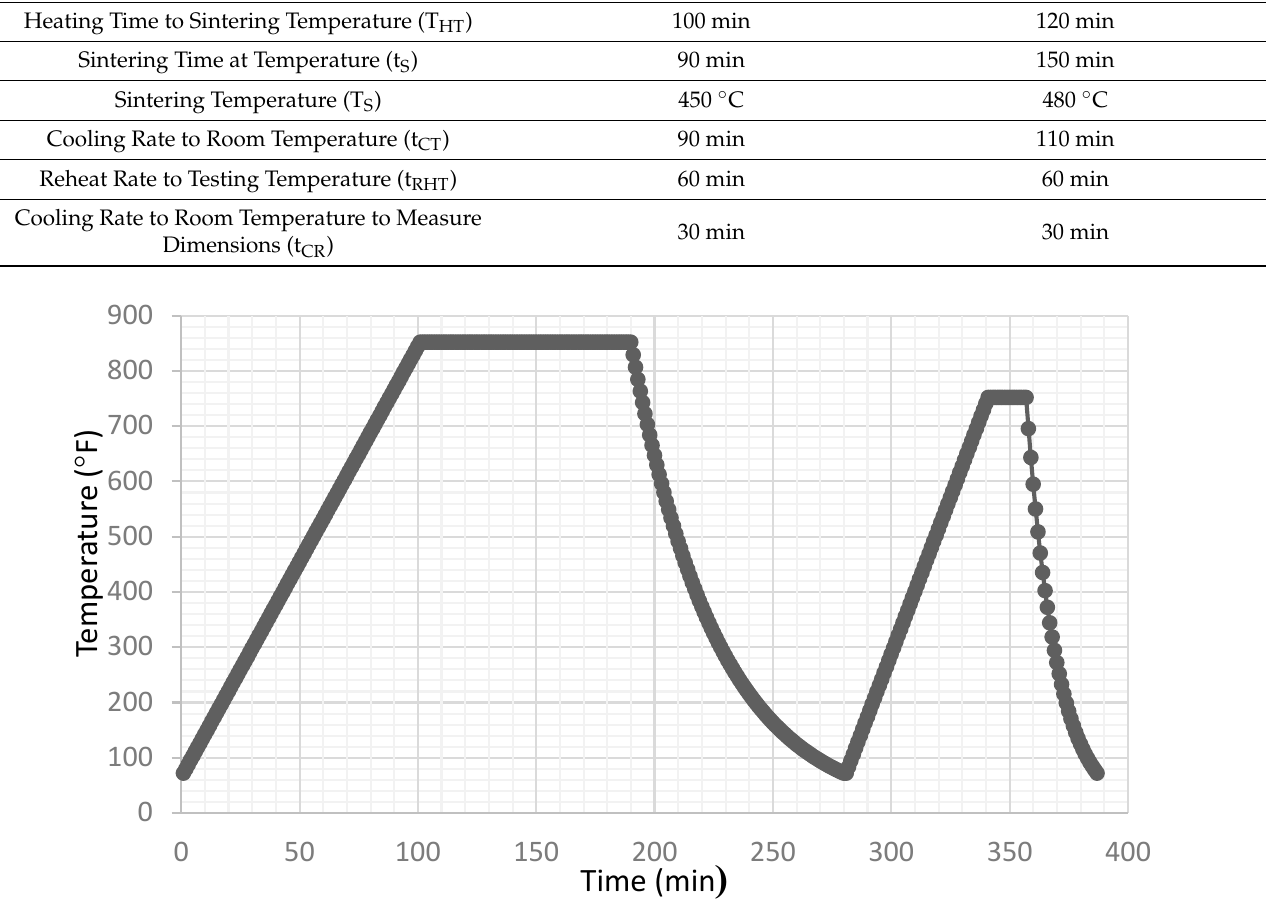
Figure 4. Sintering time–temperature profile for creating and testing deposit specimens.